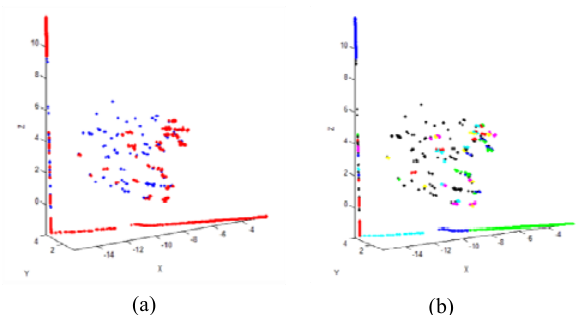
Figure 2.Line segment extraction: (a) “smooth points” (red) and “scattered points” (blue); (b) “Continuous smooth points” are clustered into line segments (colour) and scattered points